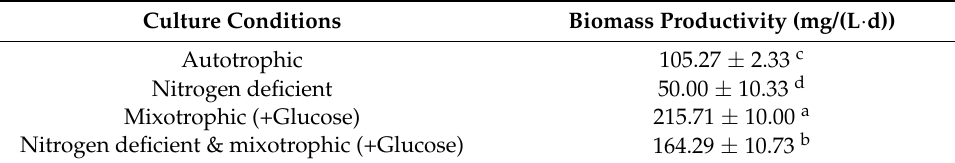
Figure 1. Changes in the dry weight in P. kessleri TY under different culture conditions. (Abbrevia- tions: Aut. Autotrophic; ND. nitrogen deficient; +Glc. mixotrophic (+Glucose); ND& (+Glc). nitrogen deficient & mixotrophic (+Glucose). (Mean ± SEM, n = 3). Table 1. Biomass productivity of P. kessleri TY under different culture conditions on day